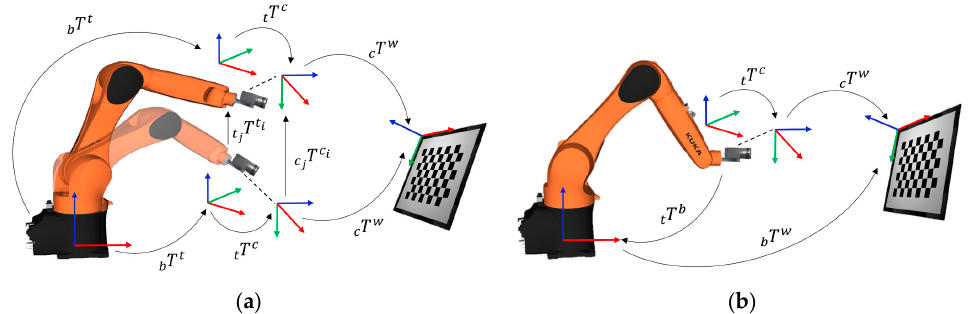
Figure 1. Formulations relating geometrical transformation for calibration; ( a ) hand–eye calibration; ( b ) robot-world-hand–eye Calibration .